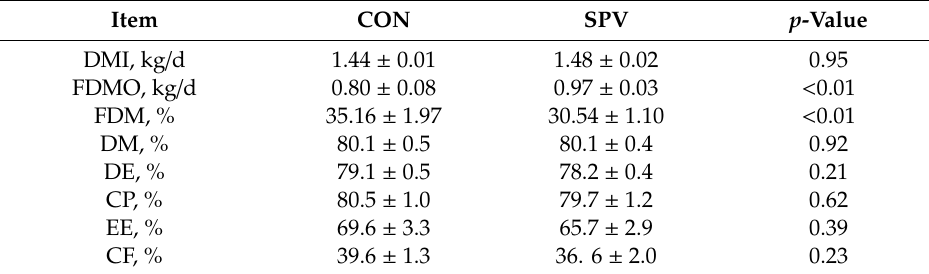
Table 1. The digestibility in Meishan gilts in di ff erent